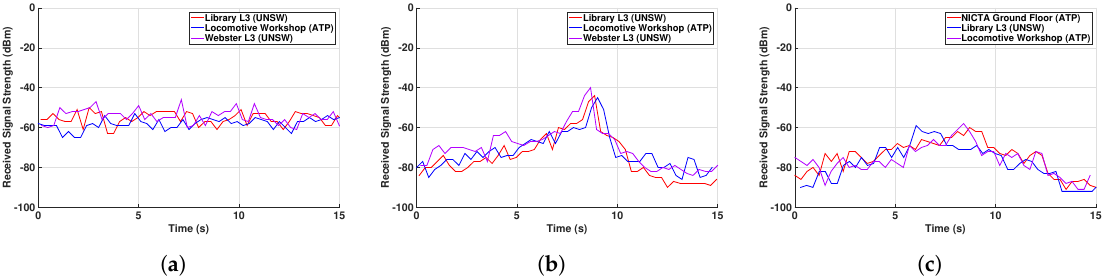
Figure 7. RSS values over time for the three different walking topologies. ( a ) Same heading path, ( b ) Opposite heading path, ( c ) Perpendicular heading